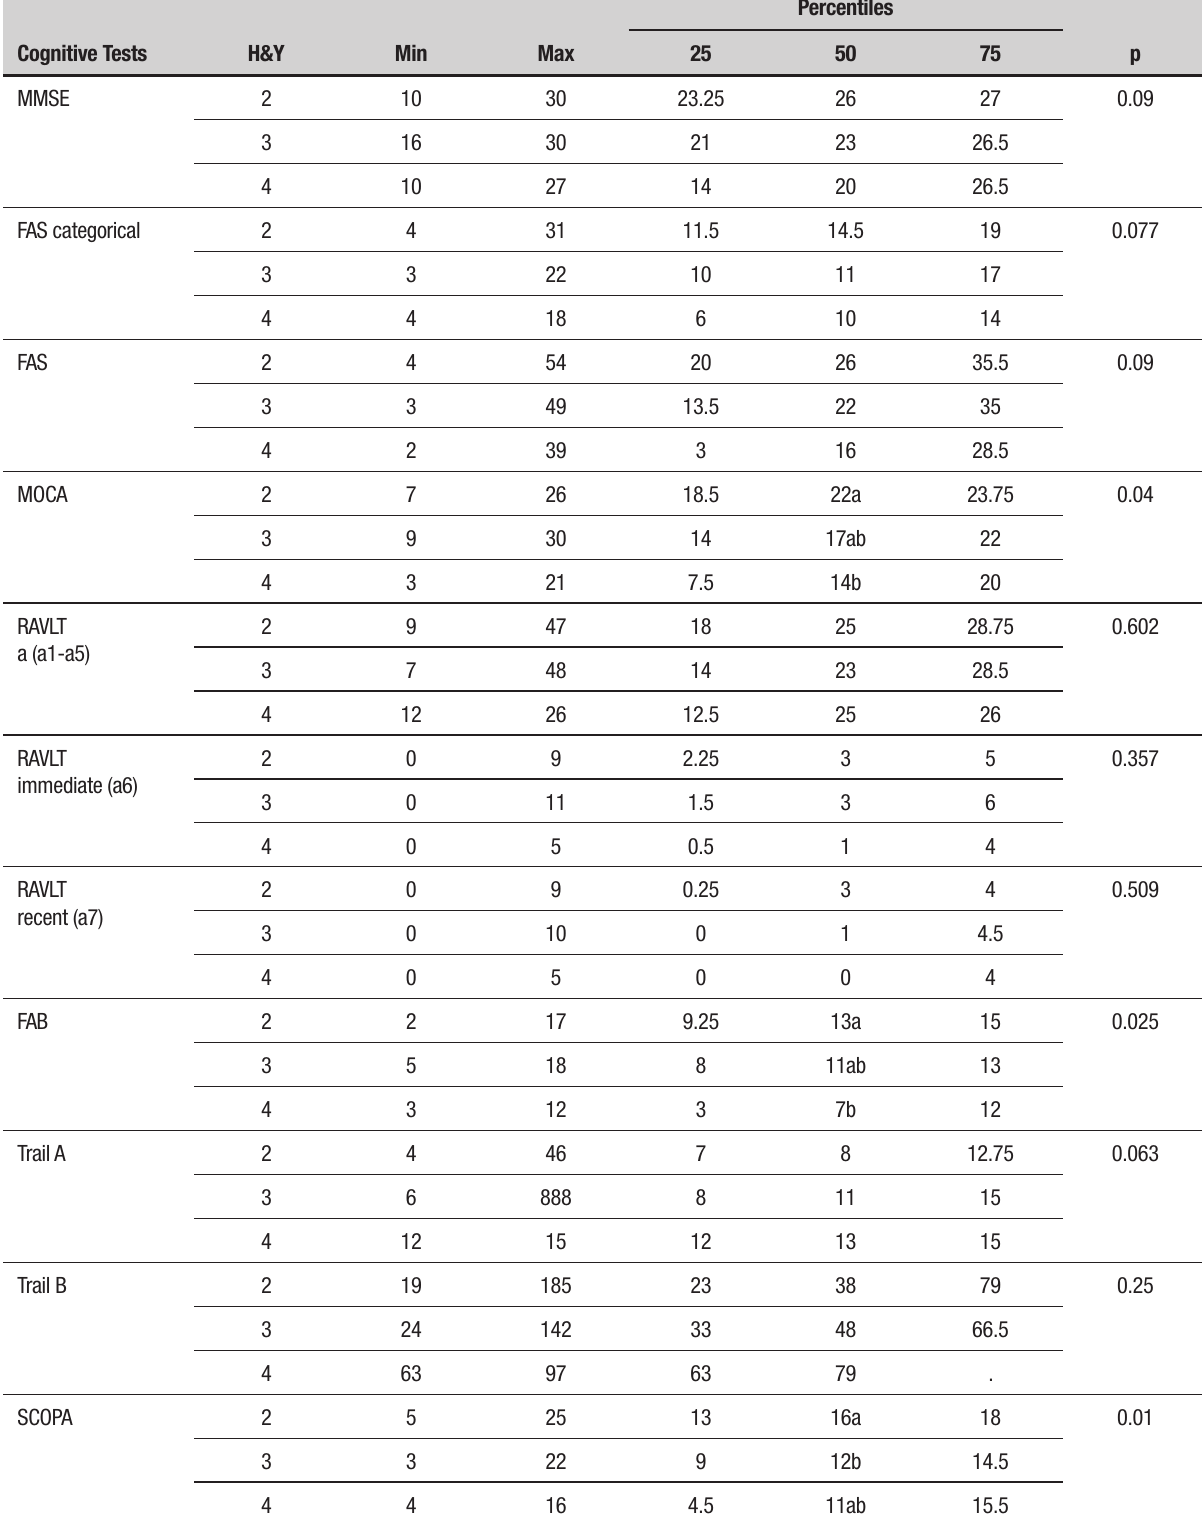
Table 3. Correlation between PD stage and cognitive assessment.